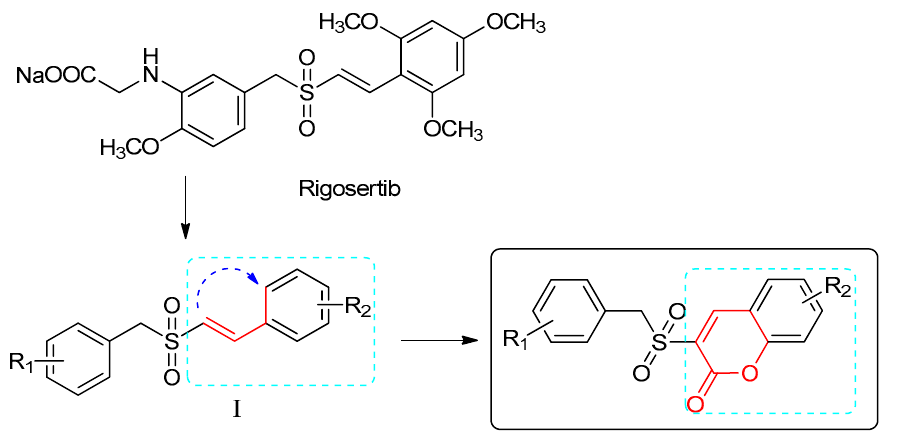
Figure 1. The design of the new benzylsulfone coumarins (II).